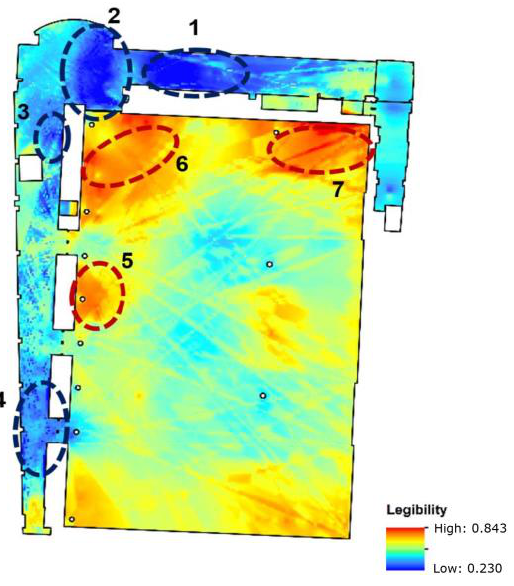
Figure 15. Calculated legibility.